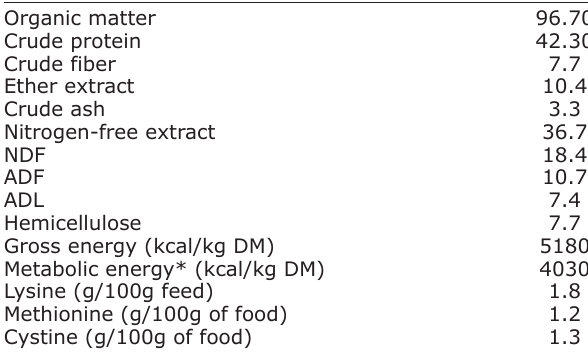
Table-2: Chemical composition of apricot kernel cake (% DM) [15].